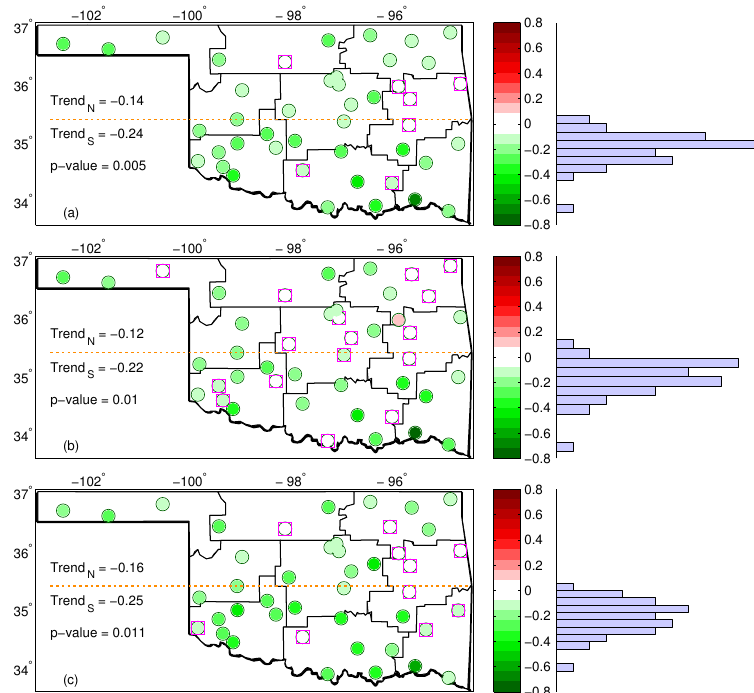
Figure 5. Individual station trends of monthly lapse rate anomalies ( ◦ C (10m) − 1 per decade) for (a) daily lapse rate, ( b ) daytime lapse rate, and (c) nighttime lapse rate. The histogram of individual station trends is presented to the right side of each panel. The x axis is the color bar of trends and the y axis represents the number of stations having that trend. Pink squares indicate non-significant trends, otherwise, the stations are significant at 95% confidence levels accounting for serial autocorrelation. The dotted orange line is the line of 35.4 ◦ in latitude to divide Oklahoma into northern and southern areas, both of which have 22 stations for evaluating averaged lapse rate trends of southern (Trend S , unit is ◦ C (10m) − 1 per decade) and northern (Trend N , ◦ C (10m) − 1 per decade) areas. The p value shown is from the two-sample t